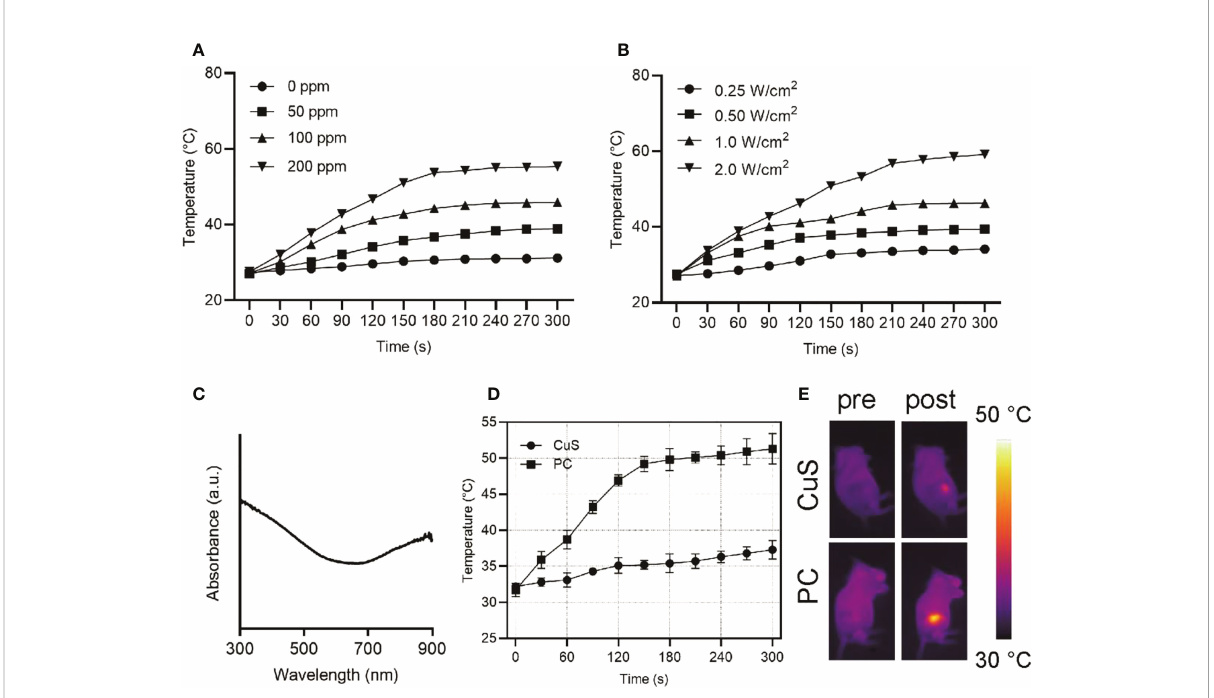
FIGURE 2 Heating curves of varying concentrations of PC upon 808 nm laser exposure at a power density of 1 W/cm 2 (A) . Heating curves of varying power density at a PC concentration of 100 ppm upon 808 nm laser exposure (B) . UV-vis-NIR absorption spectra of PC at a concentration of 100 ppm (C) . Temperature change curves of tumors of mice administrated with CuS or PC after exposure to 808 nm laser at 1.5 W/cm 2 (D) and IR images (E)